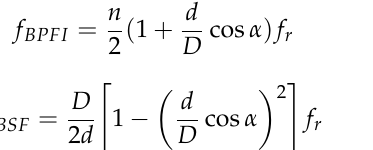
Figure 6. The experimental platform.